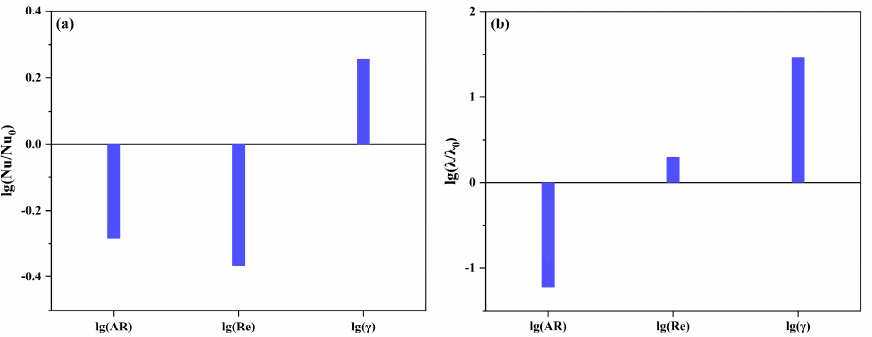
Figure 7. Coefficients Plots: (a) coefficients for lg(𝐴𝑅), lg(𝑅𝑒),lg(𝛾) on lg(𝑁𝑢/𝑁𝑢 (cid:2868) ) . (b) coefficients for lg(𝐴𝑅),lg(𝑅𝑒), lg(𝛾) on lg(𝜆/𝜆 (cid:2868) ) .